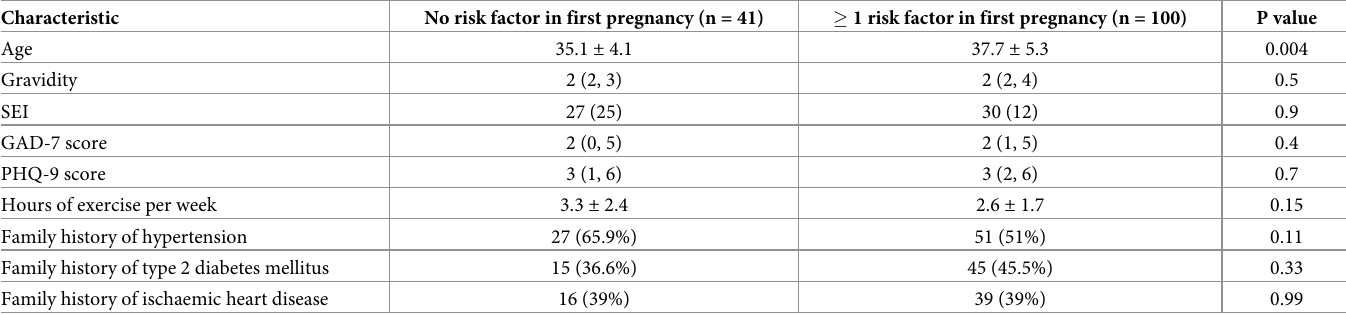
Table 1. Characteristics of the study population at 10 years postpartum.